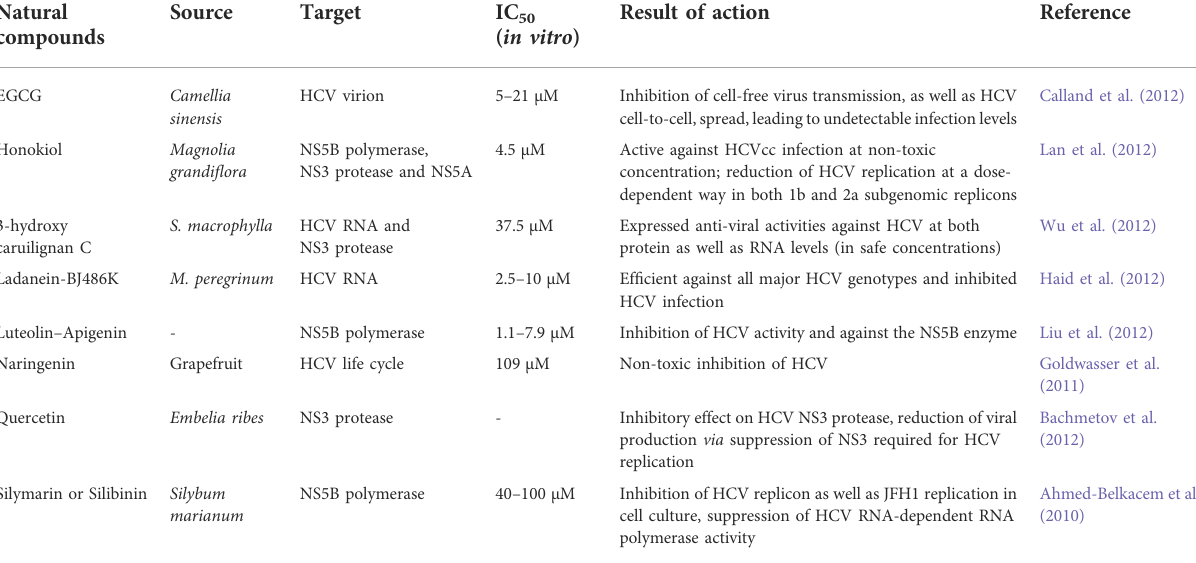
TABLE 3 Natural products for Hepatitis C